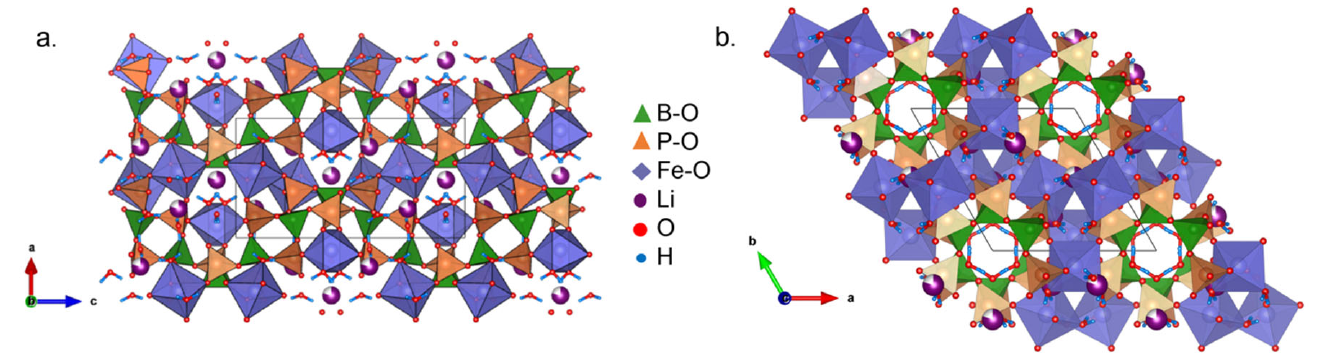
Figure 8. Structure of the LiFe-BPO cathode [109]. The polyhedral connectivity of LiFe-BPO viewed along the ( a ) b-axis and ( b ) c-axis. The 1 ∞ [( B2P4 Φ 16) m ] ( Φ = O, OH) helical chains form a channel structure filled with free water molecules. The channels are interconnected by FeO 6 polyhedra, forming gaps in the structure that host the Li + ion.